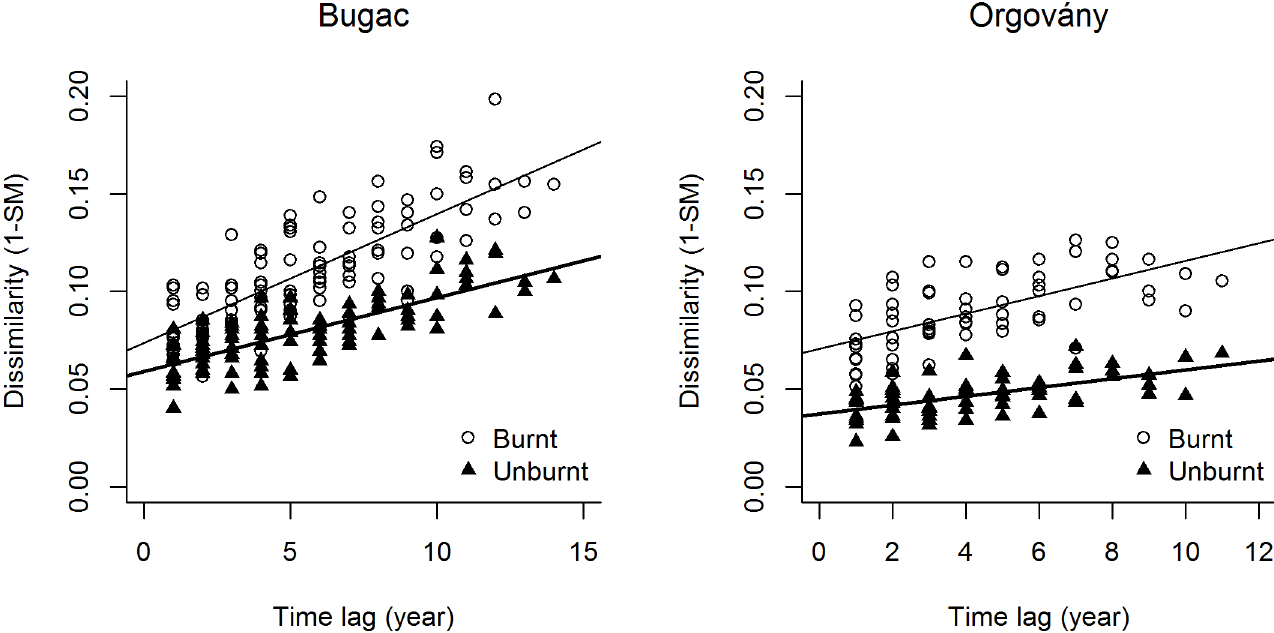
Fig 1. The compositional dissimilarity as a function of time lag on the two sites. Trend lines for illustrative purposeare fitted for significant relationships (bold for unburnt, simple line for burnt areas) accordingto Mantel-tests.